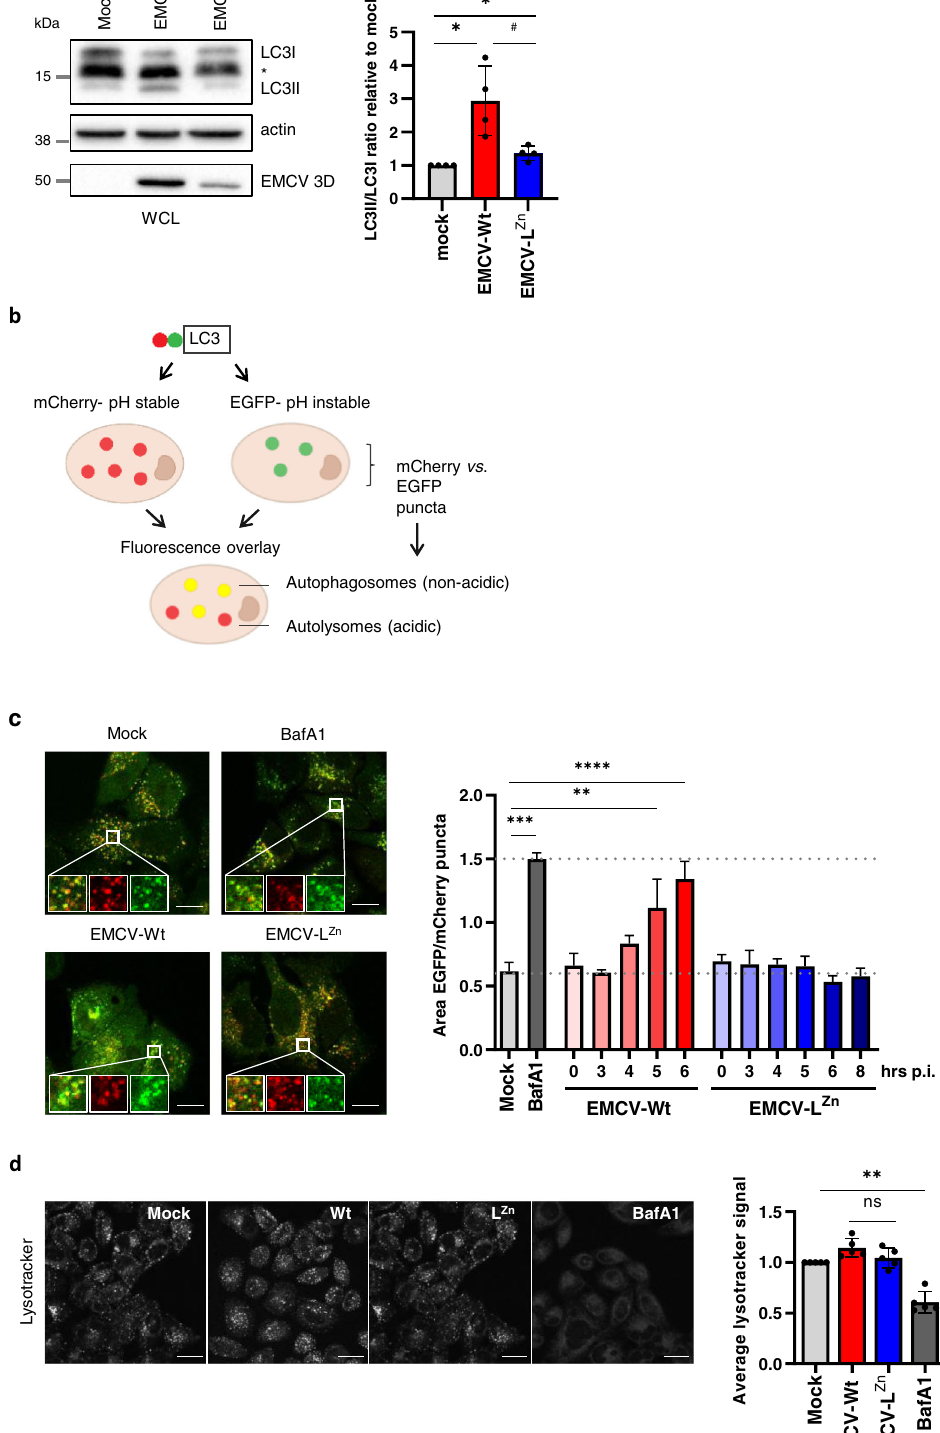
with the induction of LC3 secretion was demonstrated, high- lighting the involvement of a secretory arm of the autophagy pathway in the packaging of cargo molecules in EV. Similarly, we observed a correlation between the extracellular release of LC3 and the enhanced packaging of EMCV in EVs during